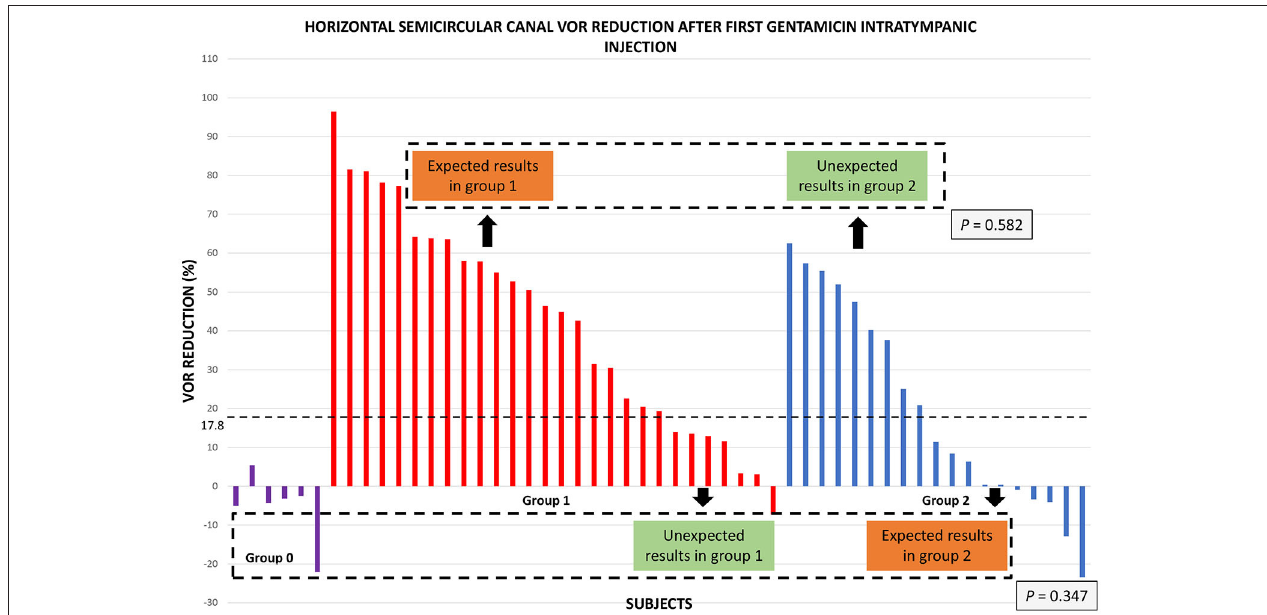
FIGURE 4 | Horizontal semicircular canal VOR reduction 1 month after the first ITG injection. The bars represent the VOR reduction in every subject of the study. The dotted line represents VOR reduction cut point of 17.8% of the previous study which predicted the need for one or more ITG injections for vertigo control. According to this criterion, expected results in group 1 exceed this cut point, and unexpected results are below this cut point. On the other hand, unexpected results in group 2 exceed this VOR reduction value, and expected results are below this cut point. Note that VOR reduction values in the untreated group (group 0) are all of them below this cut-point. Dotted squares represent comparison between subgroups with VOR reduction above the cut-point and between subgroups below the cut-point and the control group ( P values are located at the inferior right angle).